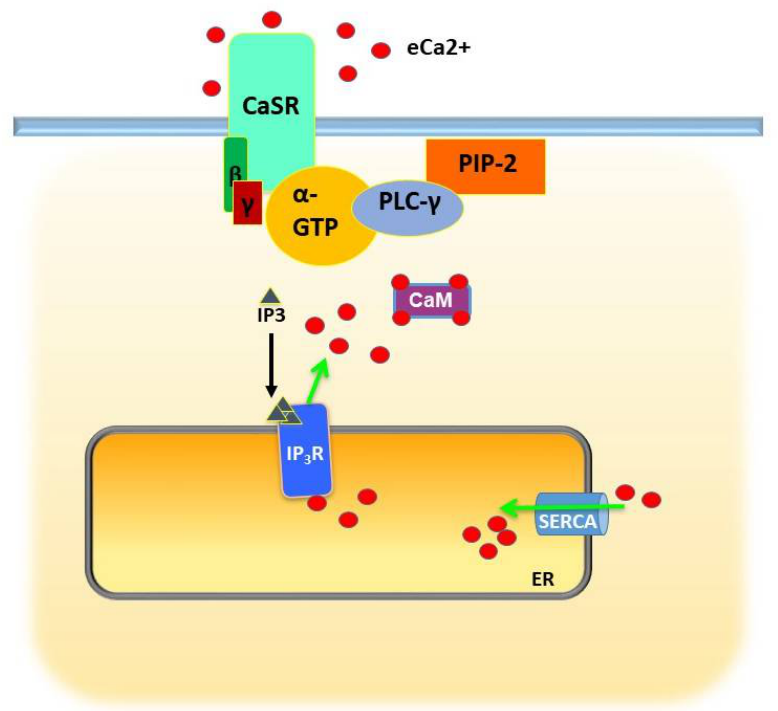
Figure 2. Role of calcium-sensing receptor (CaSR) in detecting extracellular (e) Ca 2+ and signaling the release of intracellular (i) Ca 2+ in response. Binding of eCa 2+ to CaSR stimulates PLC gamma to generate IP3 which then binds to its receptor channel on the ER, triggering release of sequestered Ca 2+ . Cytosolic Ca 2+ can then activate various signaling pathways by binding to CaM or other calcium-binding proteins. Excess Ca 2+ is resequestered by SERCA pumps. Green arrow indicates direction of flow. Black arrow indicates activation.